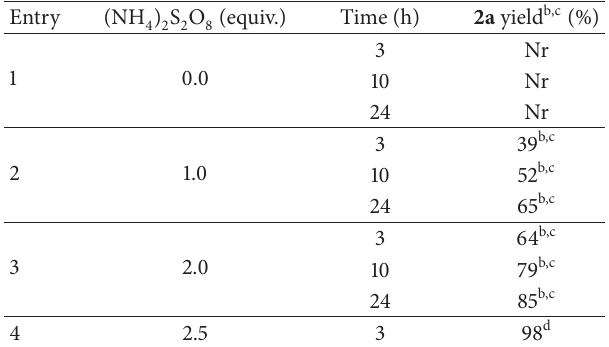
) S O on the hydroxylation of 1 a a . 4 2 2 8